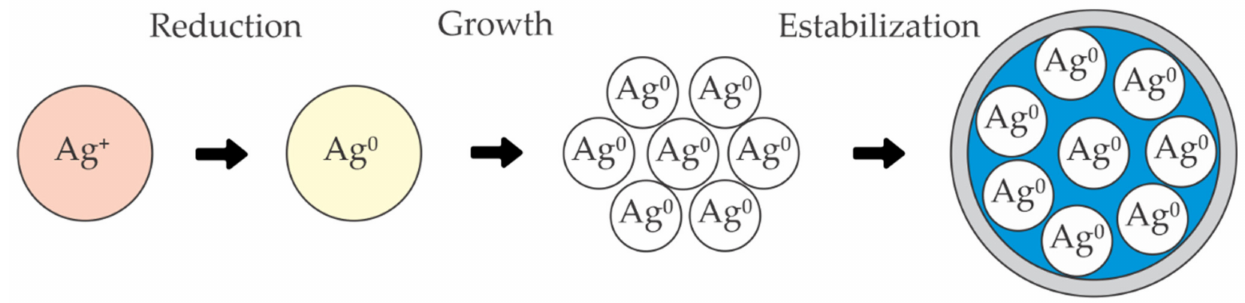
Figure 10. Scheme of the green synthesis of silver nanoparticles. Adapted from